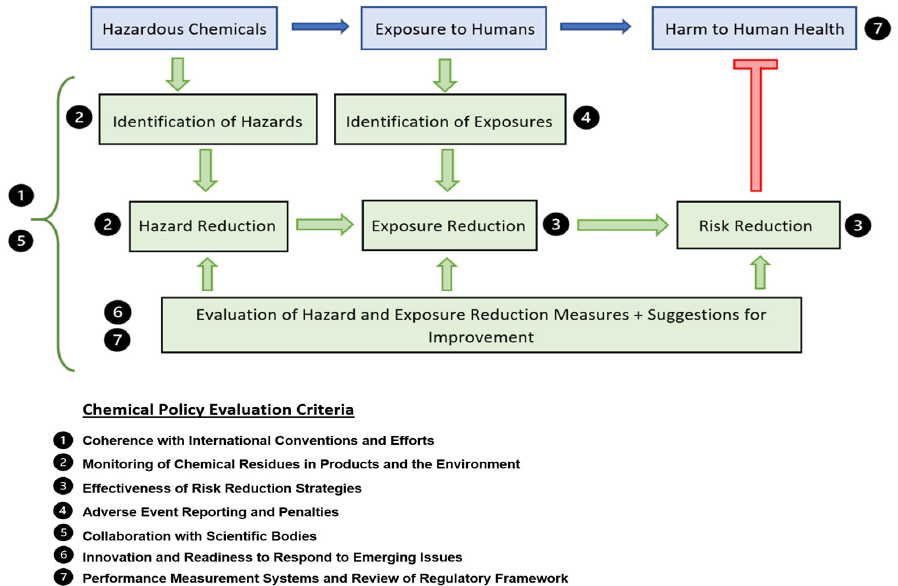
Figure 1. Hazard risk model describing the interaction between chemical hazard, exposure risk, and harm to human health, with corresponding chemical policy evaluation criteria.